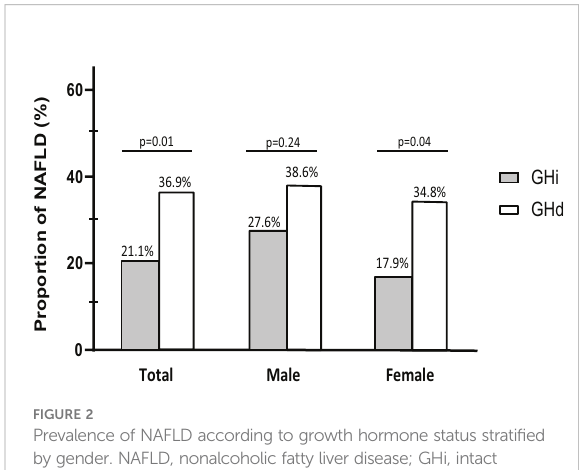
FIGURE 2 Prevalence of NAFLD according to growth hormone status strati fi ed by gender. NAFLD, nonalcoholic fatty liver disease; GHi, intact growth hormone function; GHd, growth hormone de fi